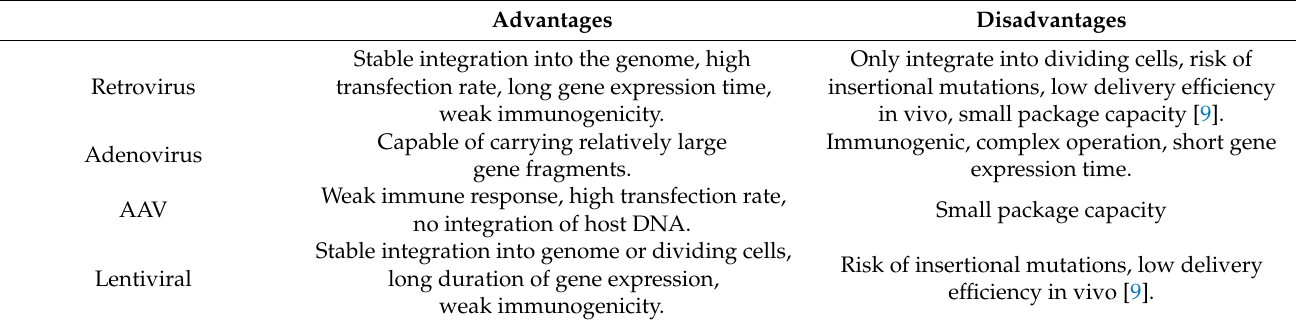
Table 3. Advantages and disadvantages of various